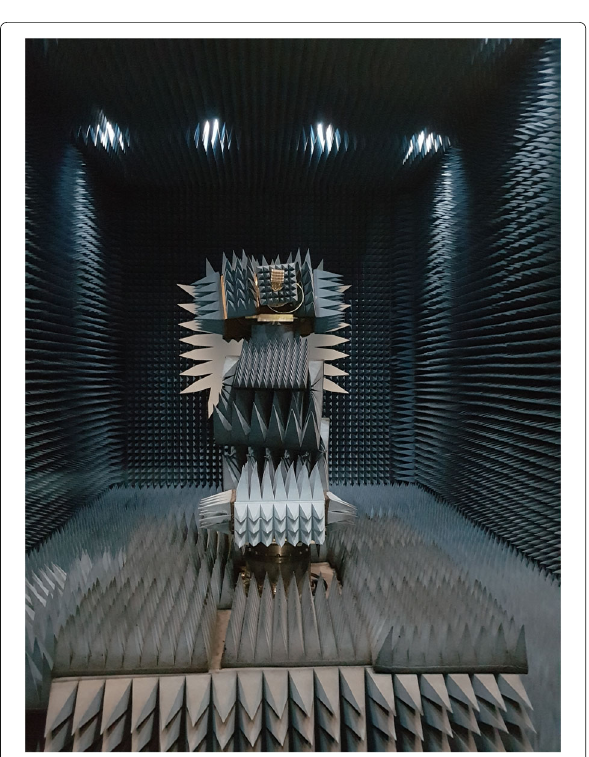
Fig. 5 Measurement of the antenna prototype in an anechoic chamber